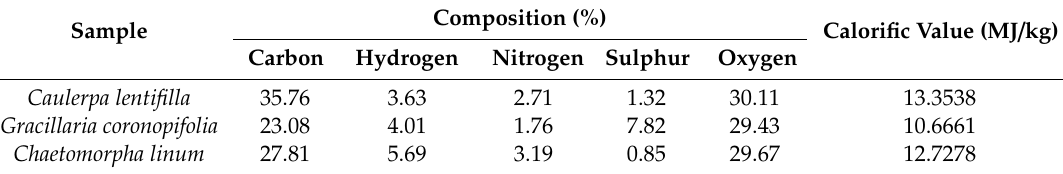
Table 1. Elemental composition and high calorific values of algal biomass samples.